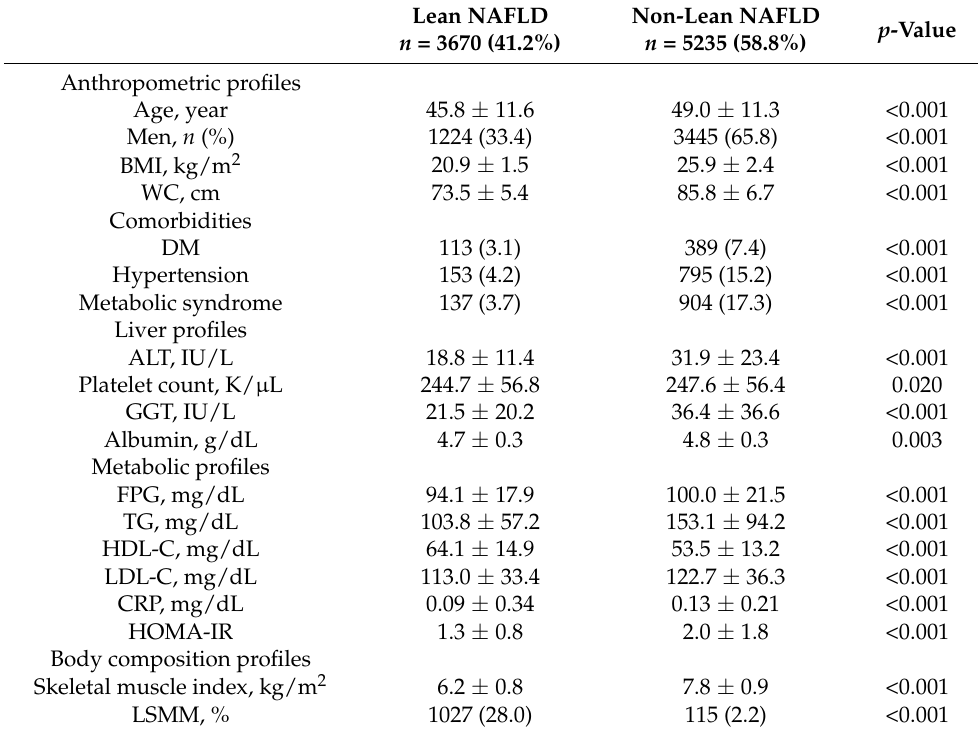
Table 1. Enrolled patients according to the presence or absence of lean NAFLD. Lean